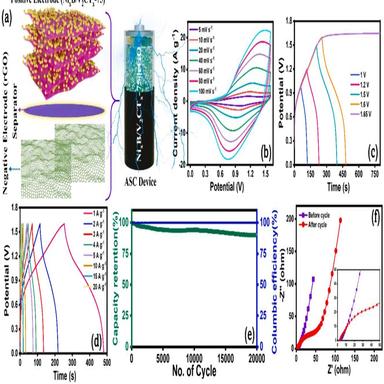
(a) Schematic representation of an asymmetric SC design; (b) CVs recorded at scan rates ranging from 5 to 100 mV s − 1 ; (c, d) GCD curves at different upper potentials and current densities ranging from 1 to 20 A g− 1 ; (e) capacity retention and Coulombic efficiency at 8 A g− 1 over 20,000 cycles; (f) impedance spectra before and after 20,000 cycles for the NixB/V2CTx-75||rGO.